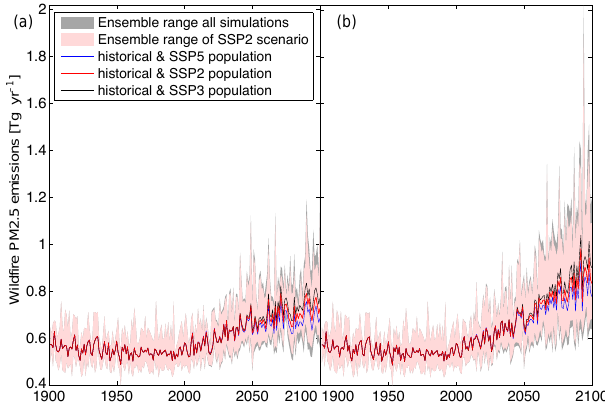
Figure 3. Ensemble means and ranges of simulated PM 2 . 5 emis- sions for all European regions for RCP4.5 (a) and RCP8.5 (b) . His- torical population data are used for 1901 to 2005 and different SSP population scenarios for the remaining